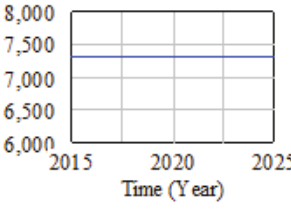
Fig. 14. Heat energy demand by CHPs and boiler-houses.